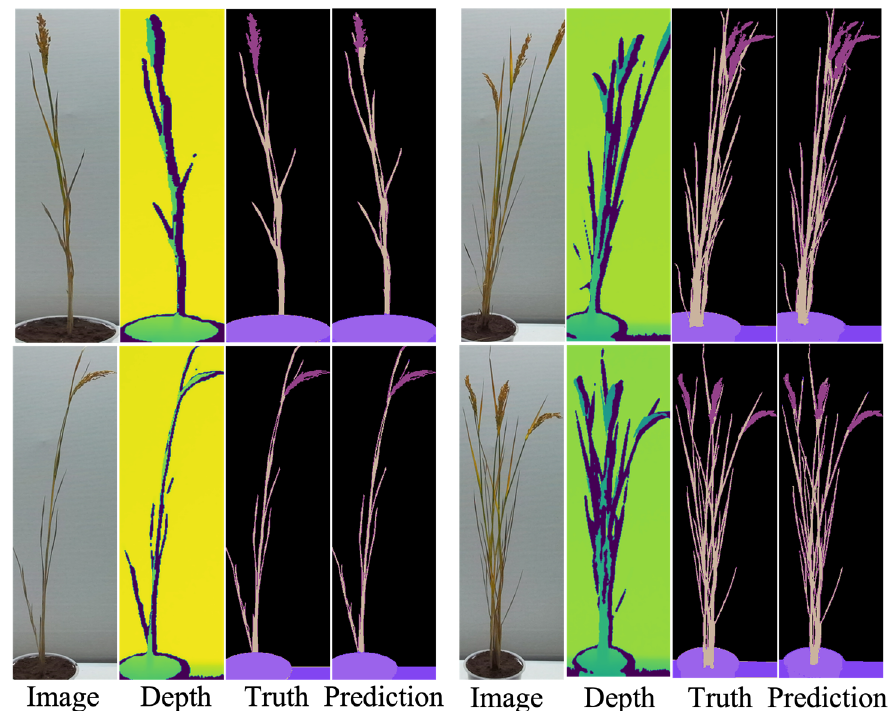
Figure 5. RICE-RGBD segmentation results.